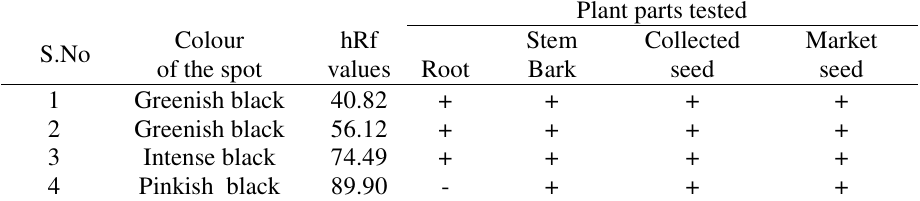
Table 8 . Qualitative separation of sterols of S.potatorum